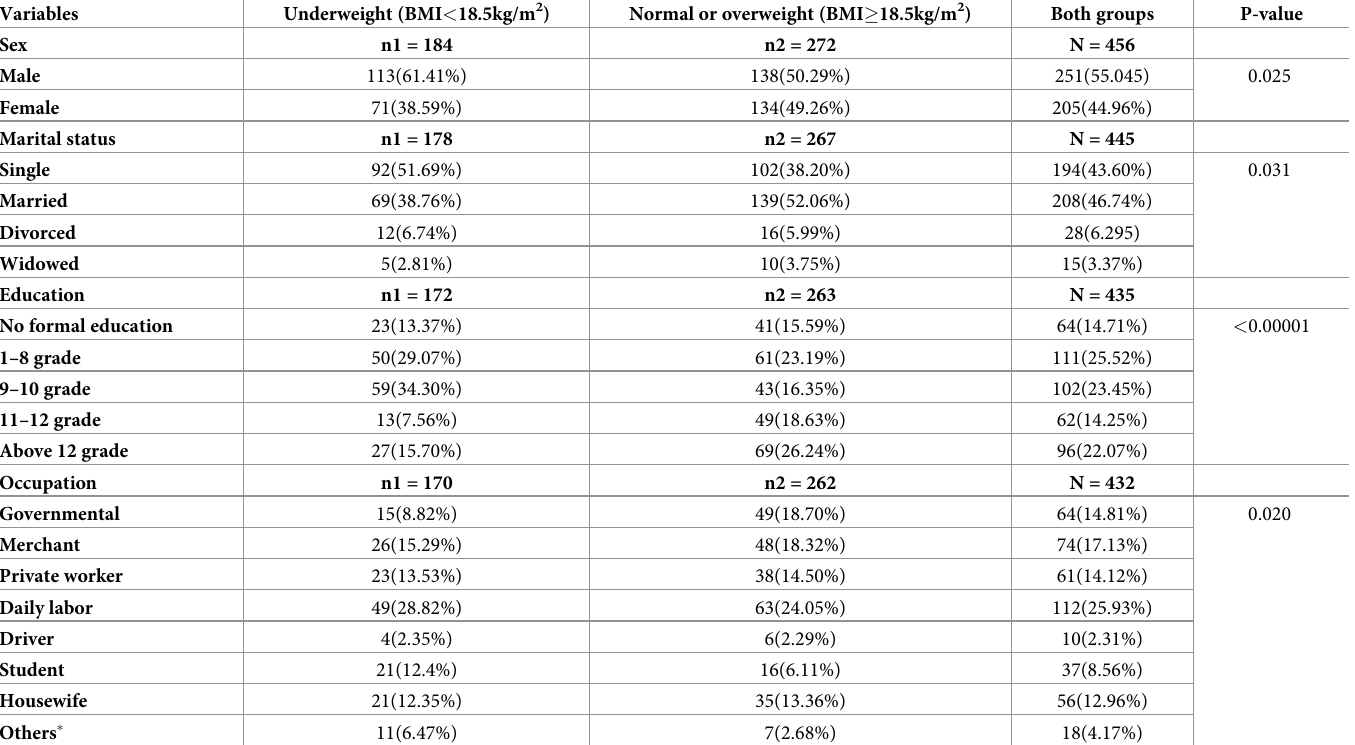
Table 1. Demographic characteristics of adult TB patients in public health centers of Addis Ababa, Ethiopia,